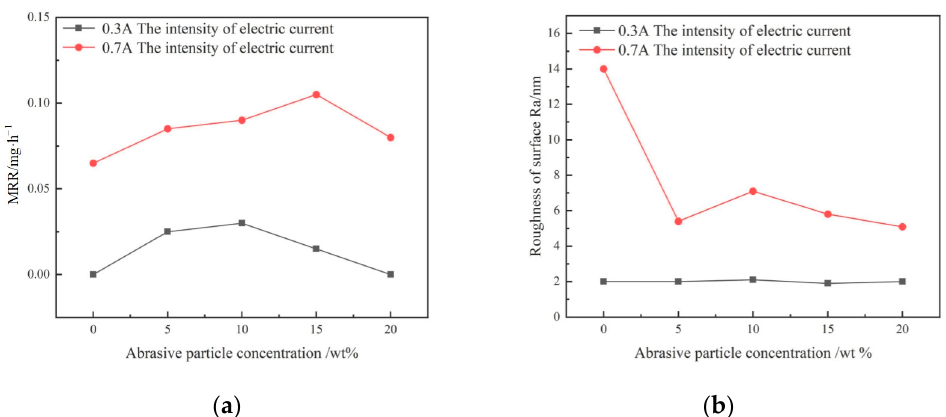
Figure 9. Curves of the material removal rate and roughness with the abrasive particle concentration. ( a ) Curve of material removal rate. ( b ) Curve of surface roughness.